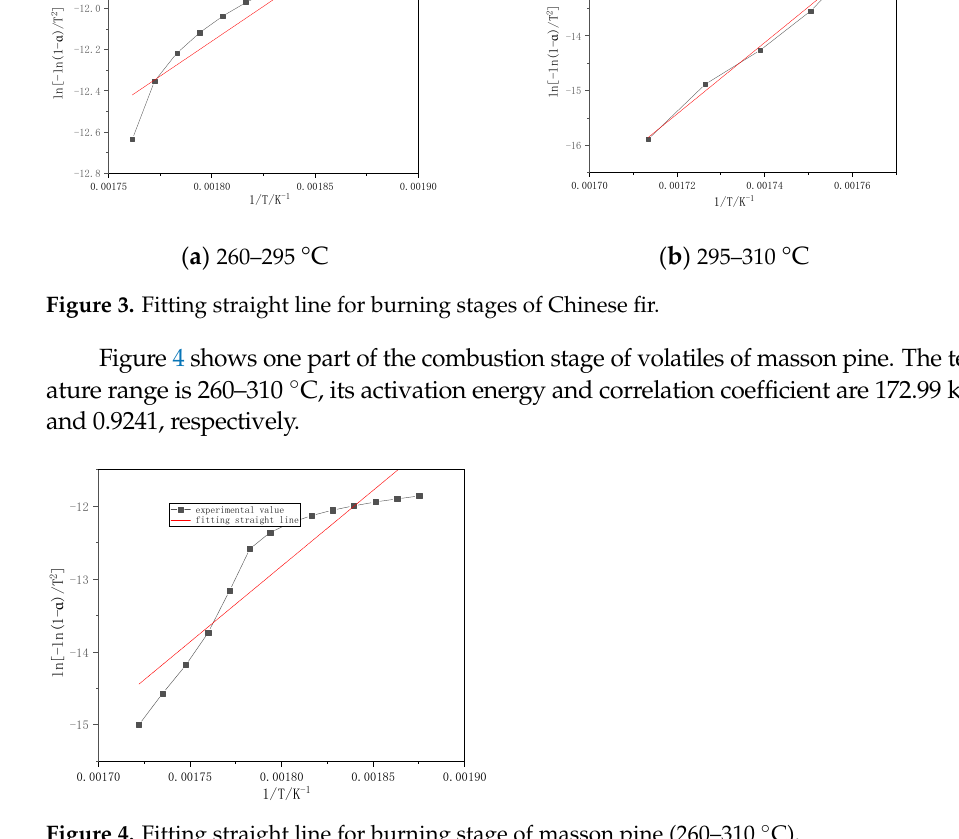
Figure 4. Fitting straight line for burning stage of masson pine (260 – 310 °C).